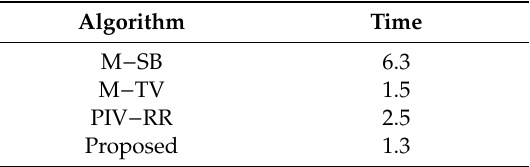
Table 9. Comparison of algorithm running time (min).